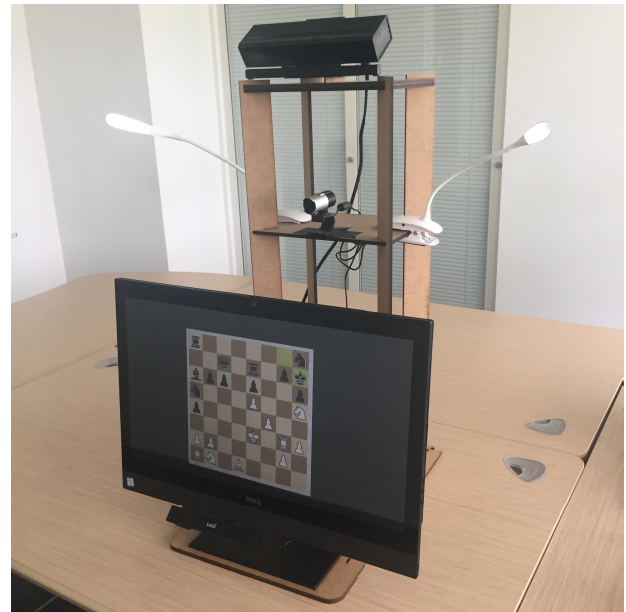
Figure 2. The experimentation equipment used for data collection. On top, a Kinect2 device looking down at the player. In the middle, a webcam to capture the face. At bottom, the touch screen equipped with an eye-tracker presenting the chess game. These views are respectively at left, right and center of Figure 1. The wooden structure is rigid to fix position and orientation of all sensors. The lighting conditions are controlled by 2 USB LED lamps on the